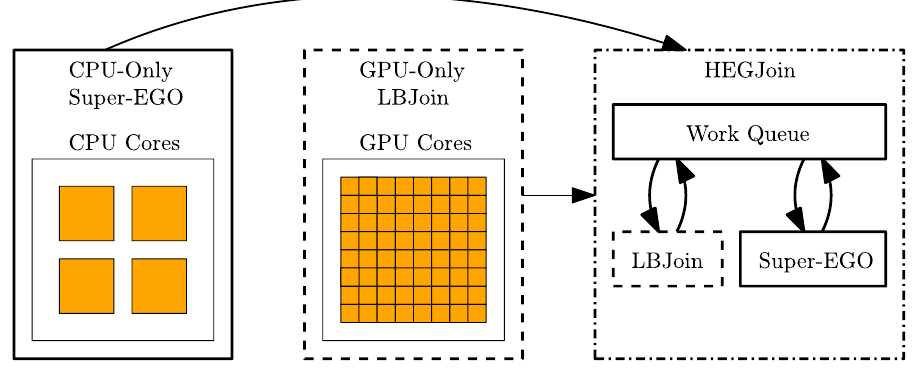
Fig. 1 Representation of how we combine S upEr -EGo and LBJ oin by using a single work queue to form HEGJ oin . When using the static partitioning strategy, the CPU and the GPU would access the work queue only once (at the beginning of the algorithm to retrieve their